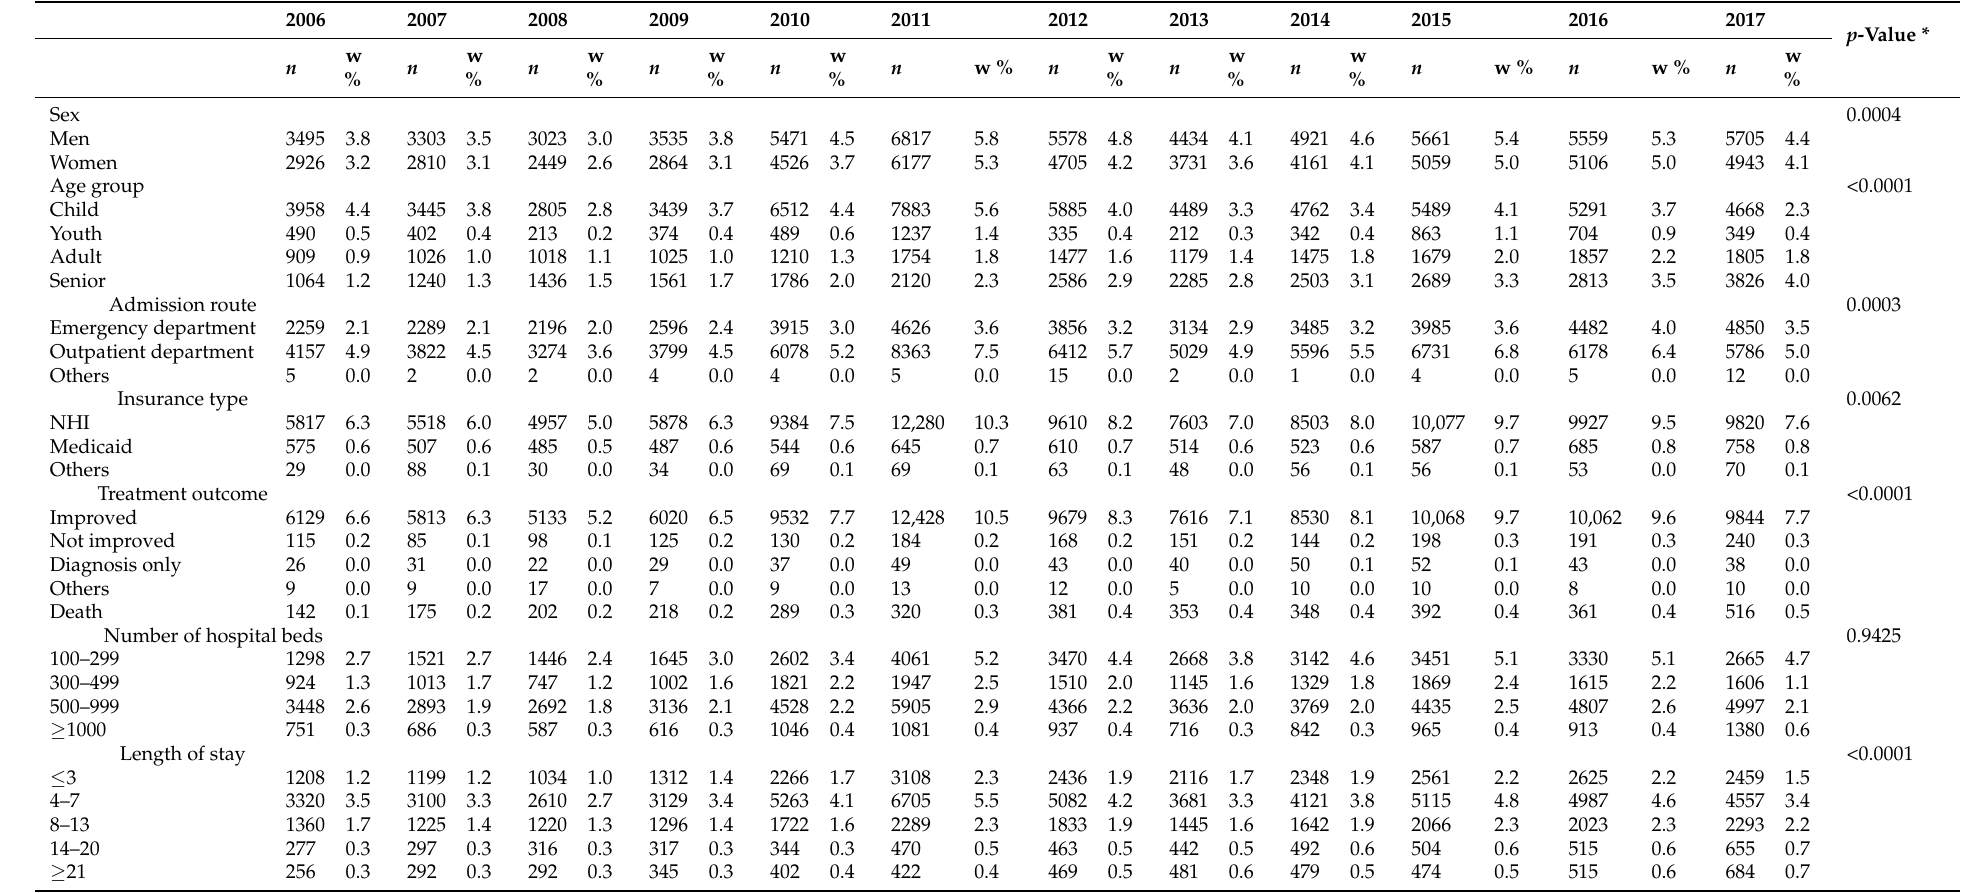
Table 2. Demographic characteristics and admission information of discharged pneumonia patients in South Korea in each year